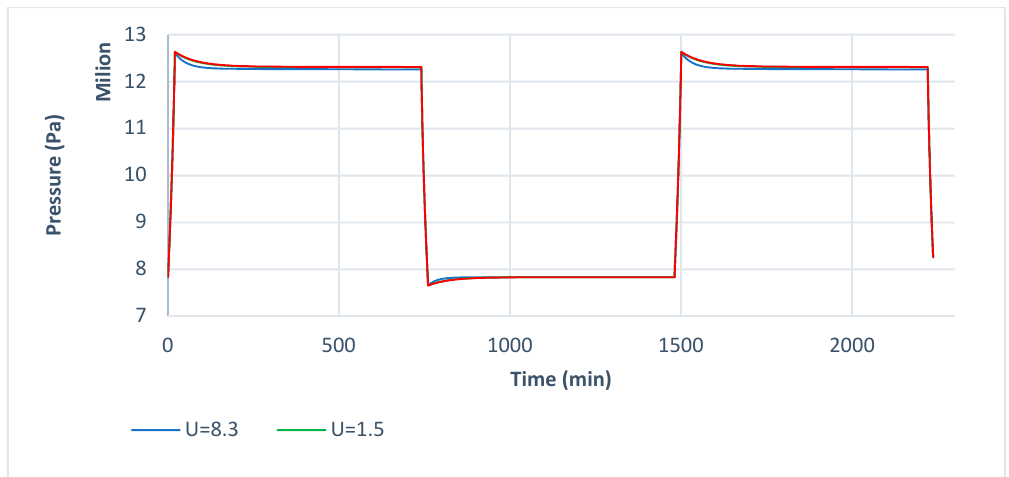
Figure 14. Gas pressure trend for the First Configuration varying the Transmittance of the tank.